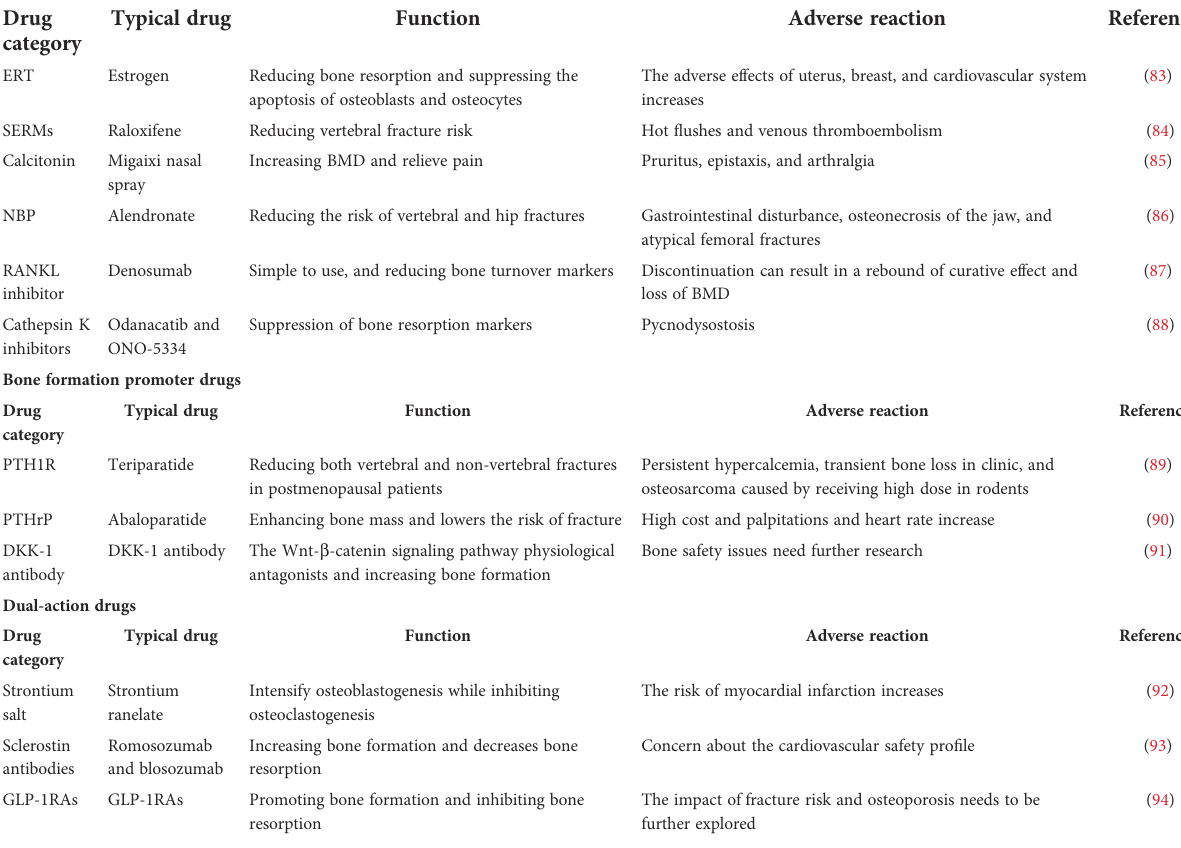
TABLE 3 The routine drug therapy in